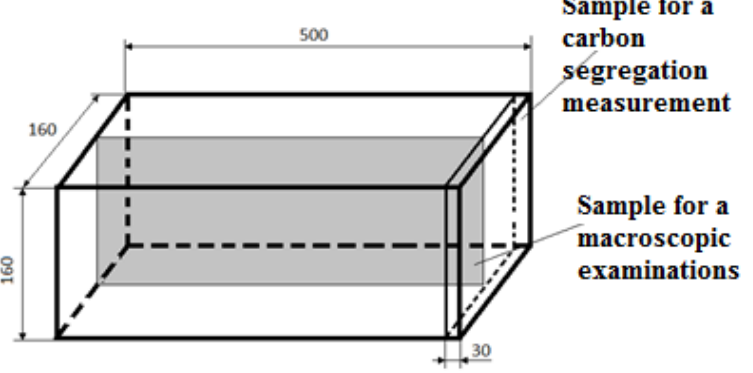
Figure 3. The shape of samples and the sampling method for macroscopic examinations and the assessment of the carbon segregation intensity.